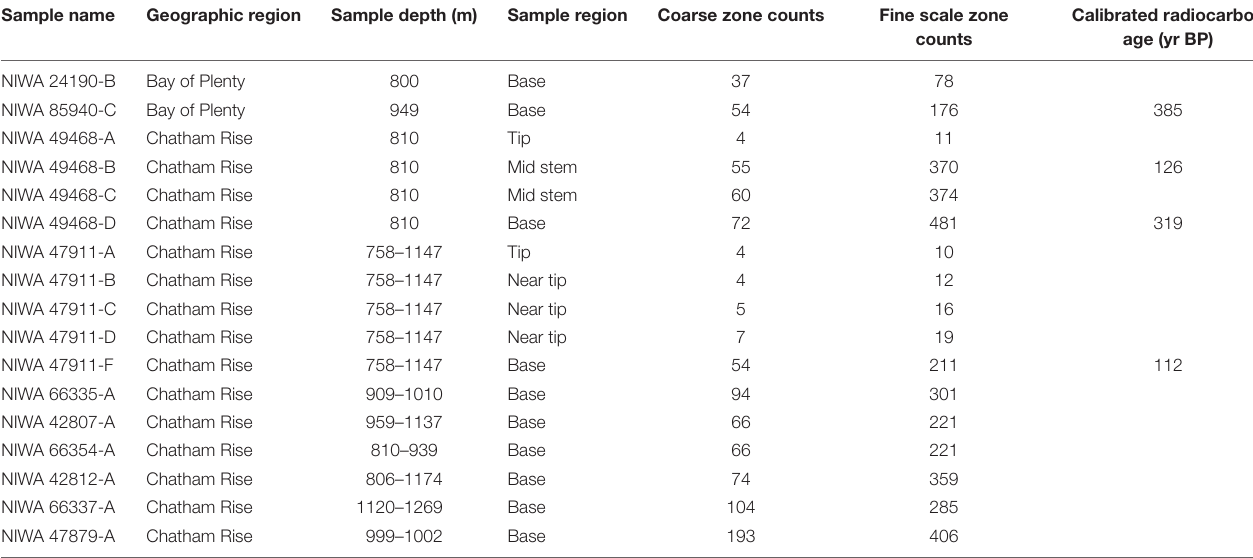
TABLE 1 | Zone counts from thin